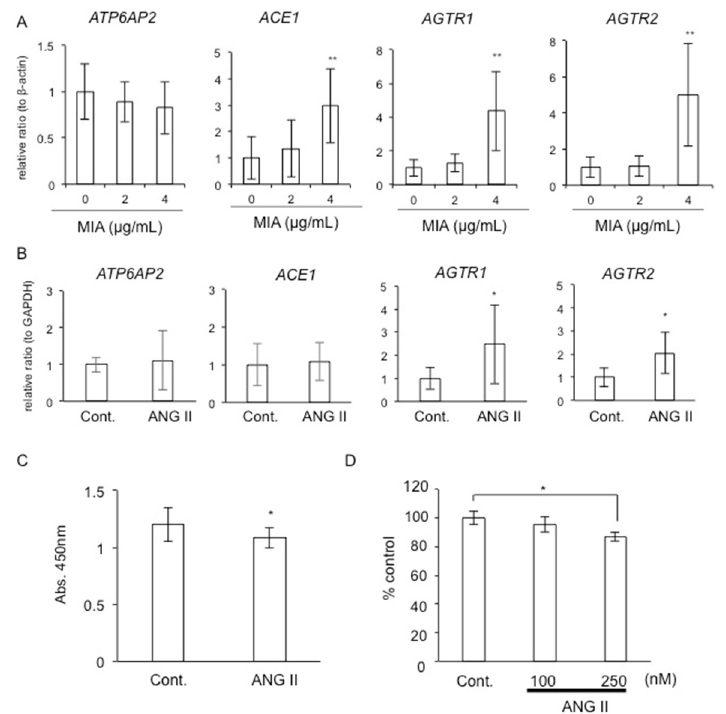
Figure 1. Decreased chondrocyte proliferation and differentiation by ANG II. ( A ) The gene expression of RAS components in HCS-2/8 cells treated with MIA. After HCS-2/8 cells had reached confluence, the cells were treated with MIA at concentrations of 2 and 4 µ g/mL for 12 h. Quantitative RT-PCR analysis was performed, and the amounts of these mRNAs were normalized to the amount of β -actin mRNA. The ordinates of the graphs indicate the relative ratio with respect to the control (ratio = 1.0). ( B ) Effect of ANG II on the gene expression of RAS components in HCS-2/8 cells. After HCS-2/8 cells had reached confluence, the cells were treated with 200 nM ANG II for 24 h. Graphs show the relative ratio with respect to the control (ratio = 1.0). ( C ) Cell proliferation assay of RCS cells treated with ANG II. RCS cells were inoculated into 96-well plates and stimulated with 200 nM ANG II at the same time. After 48 h, WST-8 was added, and the optical absorbance of culture media was measured at a wavelength of 450 nm. Each bar shows the mean and standard deviation of the results from 10 wells. ( D ) Accumulation of GAGs in RCS cells treated with ANG II. RCS cells were inoculated and stimulated with ANG II at the indicated concentrations. After 4 days, the culture media were changed, and the cells were stimulated with ANG II for another 3 days. Then, the cell lysate was prepared, and GAG content was measured. The ordinates of the graphs indicate the rel- ative ratio with respect to the control (ratio = 100%). The data were analyzed by using Bonferroni’s test to compare the data from multiple groups or unpaired Student ′ s t -test to compare the data from 2 groups. The asterisk indicates a significant difference from the control (* p < 0.05, ** p < 0.01).